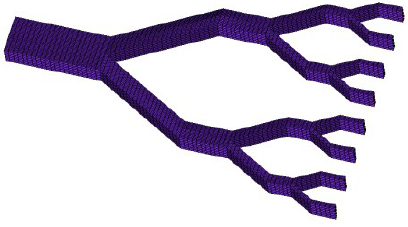
Figure 8. Finite element model of the tube.